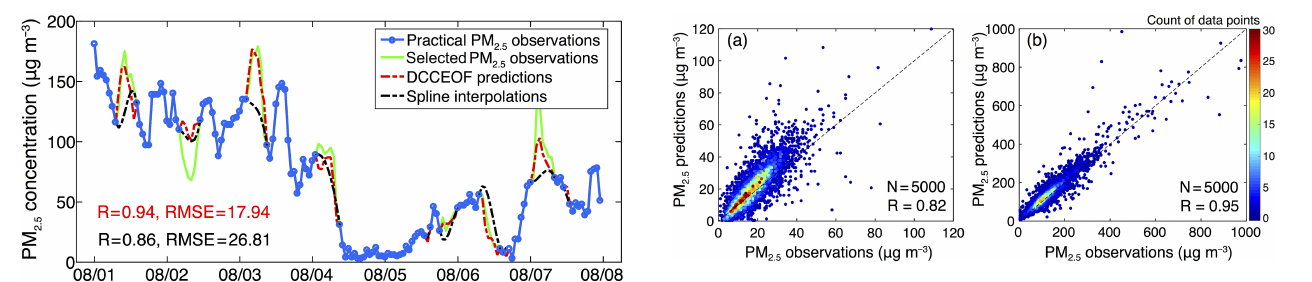
Figure 8. Comparisons of PM 2 . 5 observations with the recon- structed data values during clean (a) and polluted (b) phases. For each scenario, the results were derived from 1000d of gap-free PM 2 . 5 observations with five valid values being randomly retained from 24h of observations on each sampled date for cross